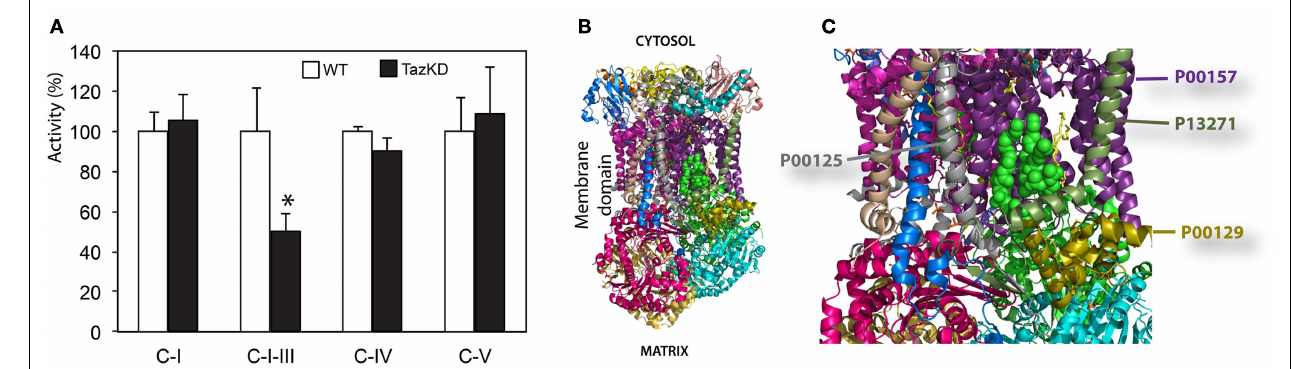
moiety in mitochondrial bc1 complex.Two cardiolipin molecules are illustrated with green balls. Phosphatidyl-ethanolamine molecules are shown as yellow sticks. Polypeptides in close proximity to phospholipid molecules are shown: cytochrome c1 (P00125, gray), cytochrome b (P00157, purple), subunit 8,